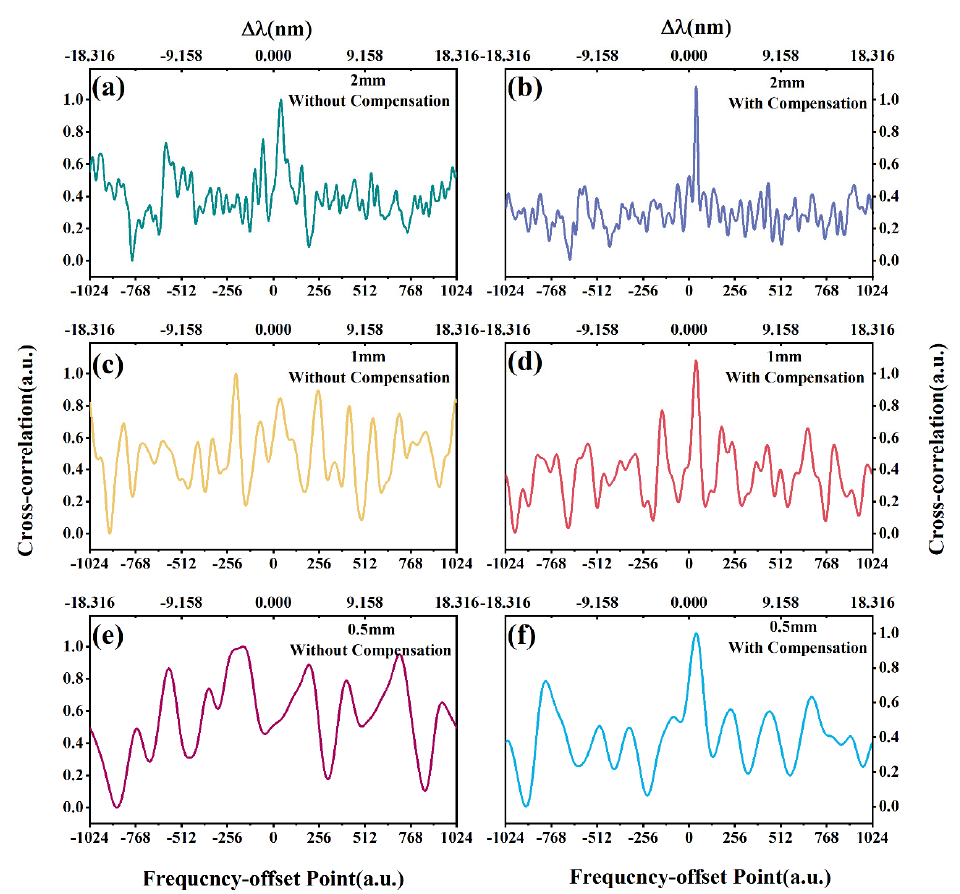
Figure 7. Cross-correlation result of RS spectra before and after position deviation correction: ( a , b ) 2 mm spatial resolution; ( c , d ) 1 mm spatial resolution; ( e , f ) 0.5 mm spatial resolution.